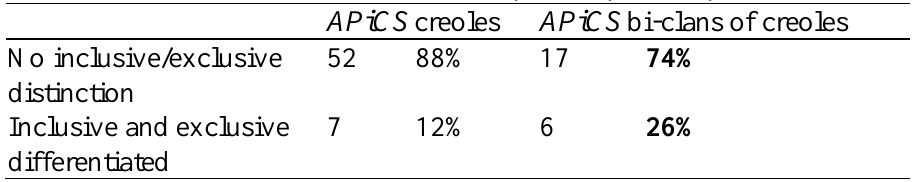
Table 7. Inclusive/exclusive distinction in independent personal